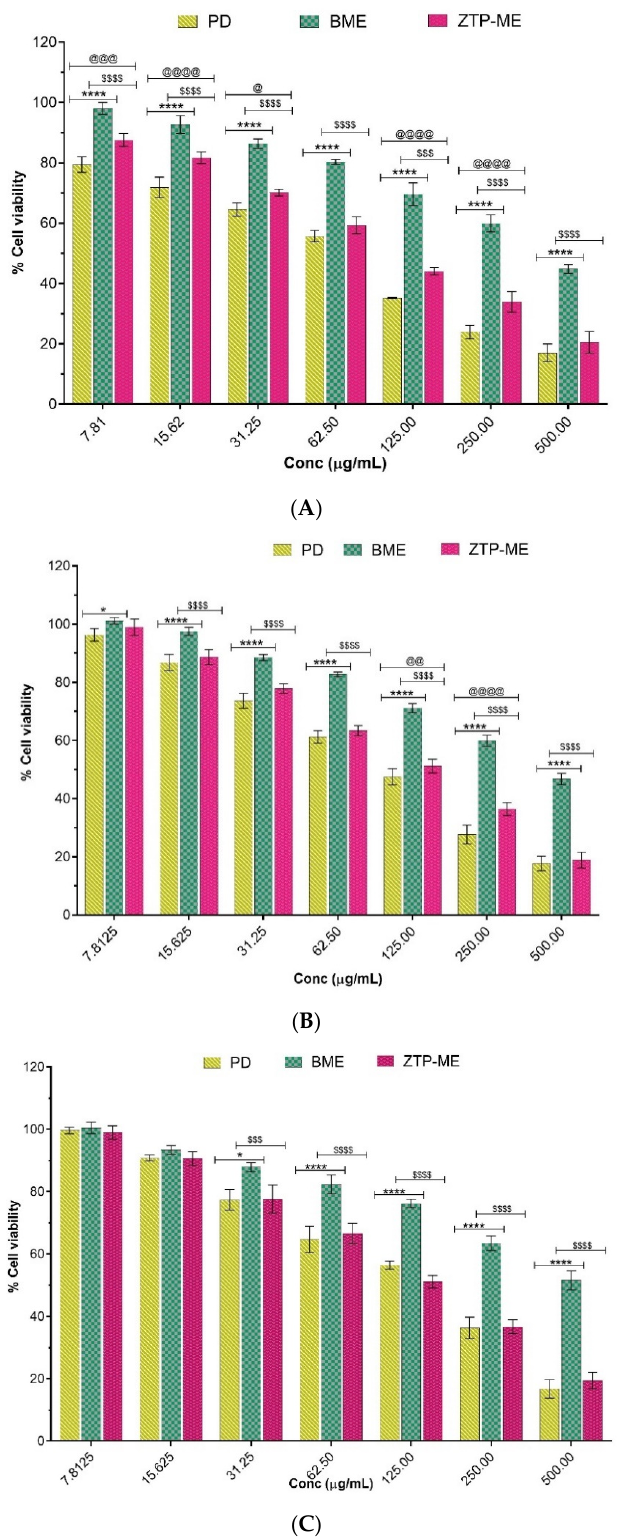
Figure 6. ( A ) Cytotoxicity of PD, BME, and ZTP-ME on RPMI 2650 cell lines (7.81–500 µ g/mL) for 48 h followed by MTT incubation. The values presented were the mean ± S.E.M ( n = 3). Abbreviations: PD = plain drug, BME = blank microemulsion, ZTP-ME = zotepine microemulsion. **** p < 0.0001